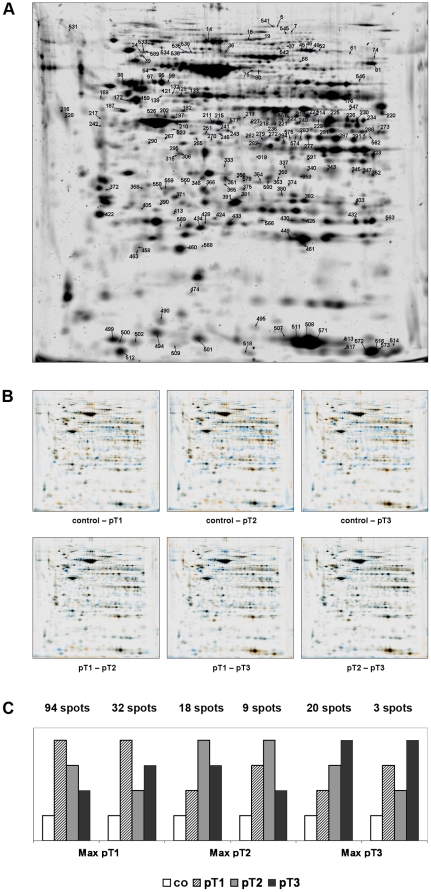
Representative 2-DE proteome map of kidney cancer.
A 2D proteome map of kidney cancer tissue (fused image), pI range 3–10 NL, 12.5% SDS-PAGE is presented. The identified proteins, which are significantly altered were labeled with numbers. B Dual channel image analysis. Differences in spot intensities were analyzed in all possible gel combinations. Each channel represents a fused gel image of all 4 technical replicates. C Representation of the possible changes between tumor stages pT1, pT2 and pT3 with different maxima. Above the bars, the number of spots that follow this trend is mentioned.